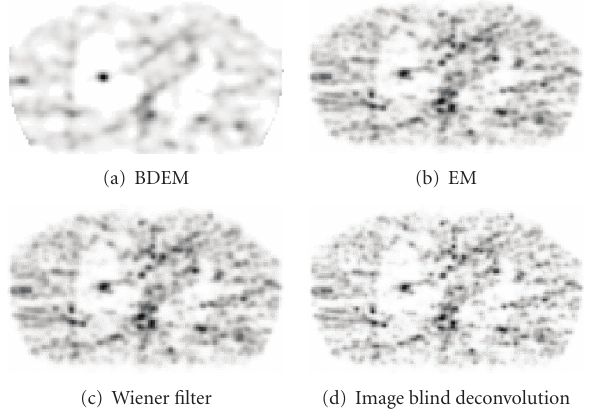
Figure 4: EM and BDEM compared to image deblurring tech- niques.